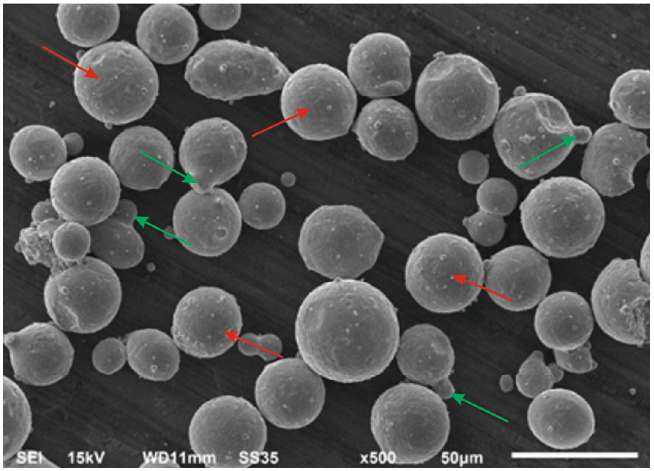
Figure 1. 21NiCrMo2 steel powder particles.